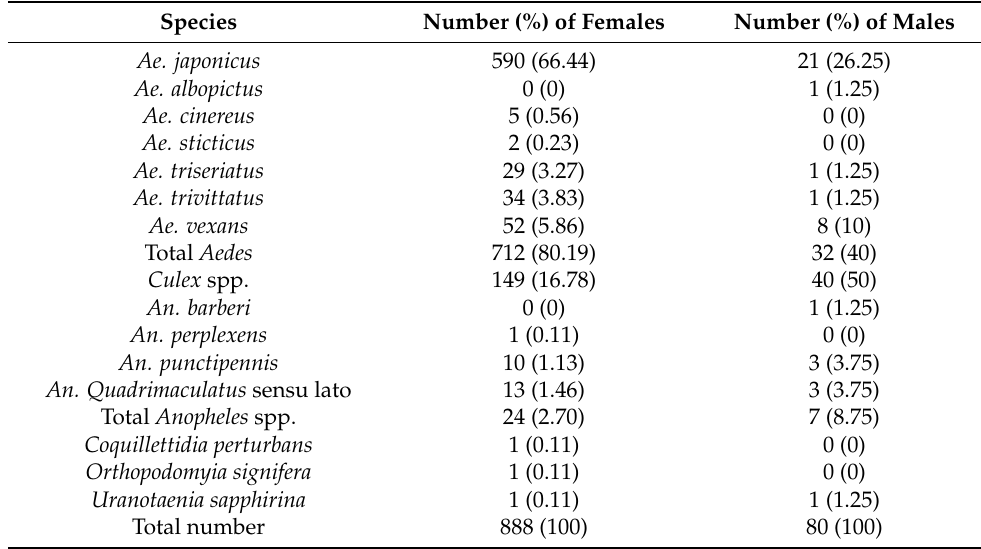
Table 1. The abundance and diversity of mosquitoes collected in Wooster. Combined counts for all trap types were used to generate this table.